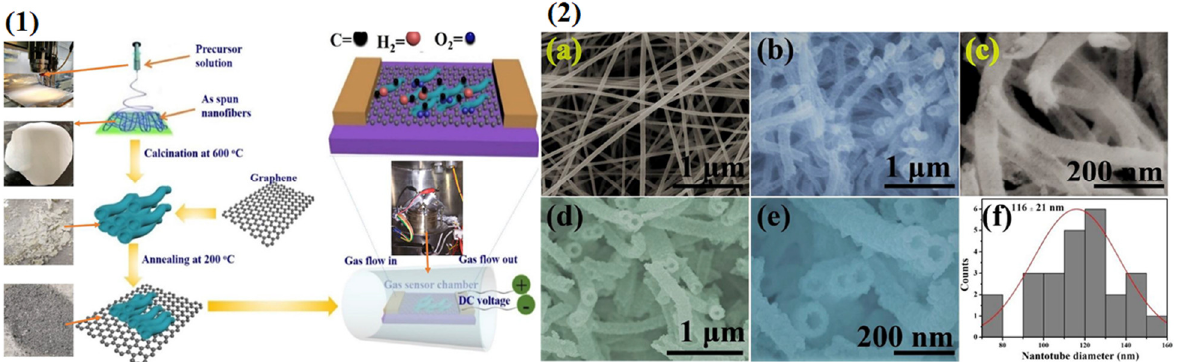
Figure 3. ( 1 ): Pristine and GO-SnO 2 NT preparation and gas sensor mechanism and ( 2 ) SEM images of ( a ) as-prepared Sn + poly (vinyl pyrrolidone) (PVP) NFs, ( b , c ) pristine SnO 2 , and ( d , e ) GO incorporated SnO 2 NTs, ( f ) histogram of GO-SnO 2 NT diameters. Reproduced with permission from [135]. Copyright 2019 Elsevier.